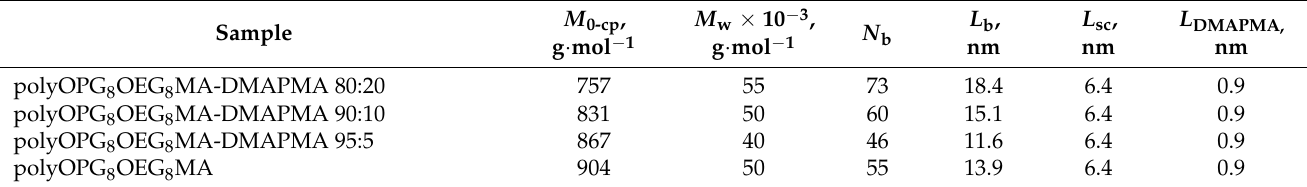
Table 2. The structure characteristics of polyOPG 8 OEG 8 MA and polyOPG 8 OEG 8